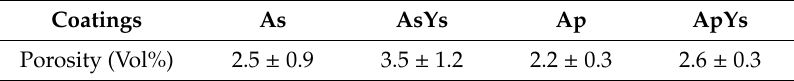
Table 2. Percentage porosity values of the